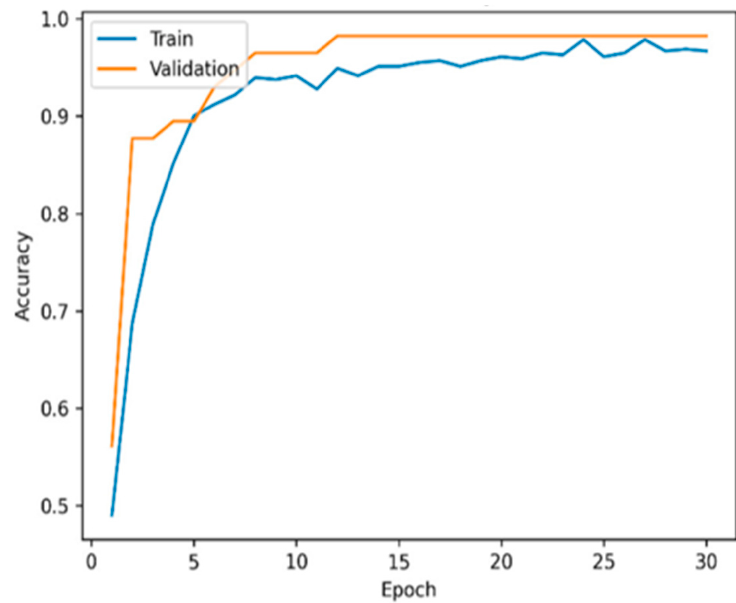
Figure 3. Model accuracy.